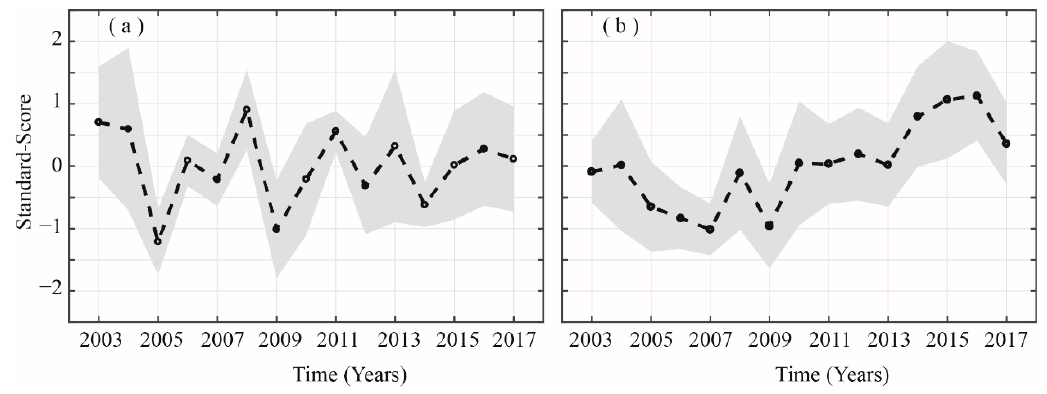
Figure 10. Standardized AOD time series during ( a ) summer and ( b ) winter over the study area. The black line shows mean standard values whereas the shaded region represents the standard deviations.